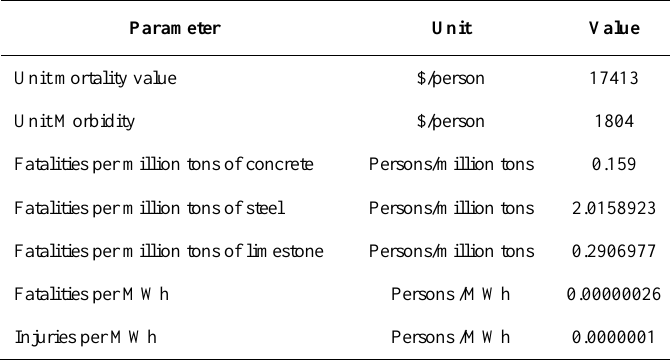
Table 5. Mortality and Morbidity model